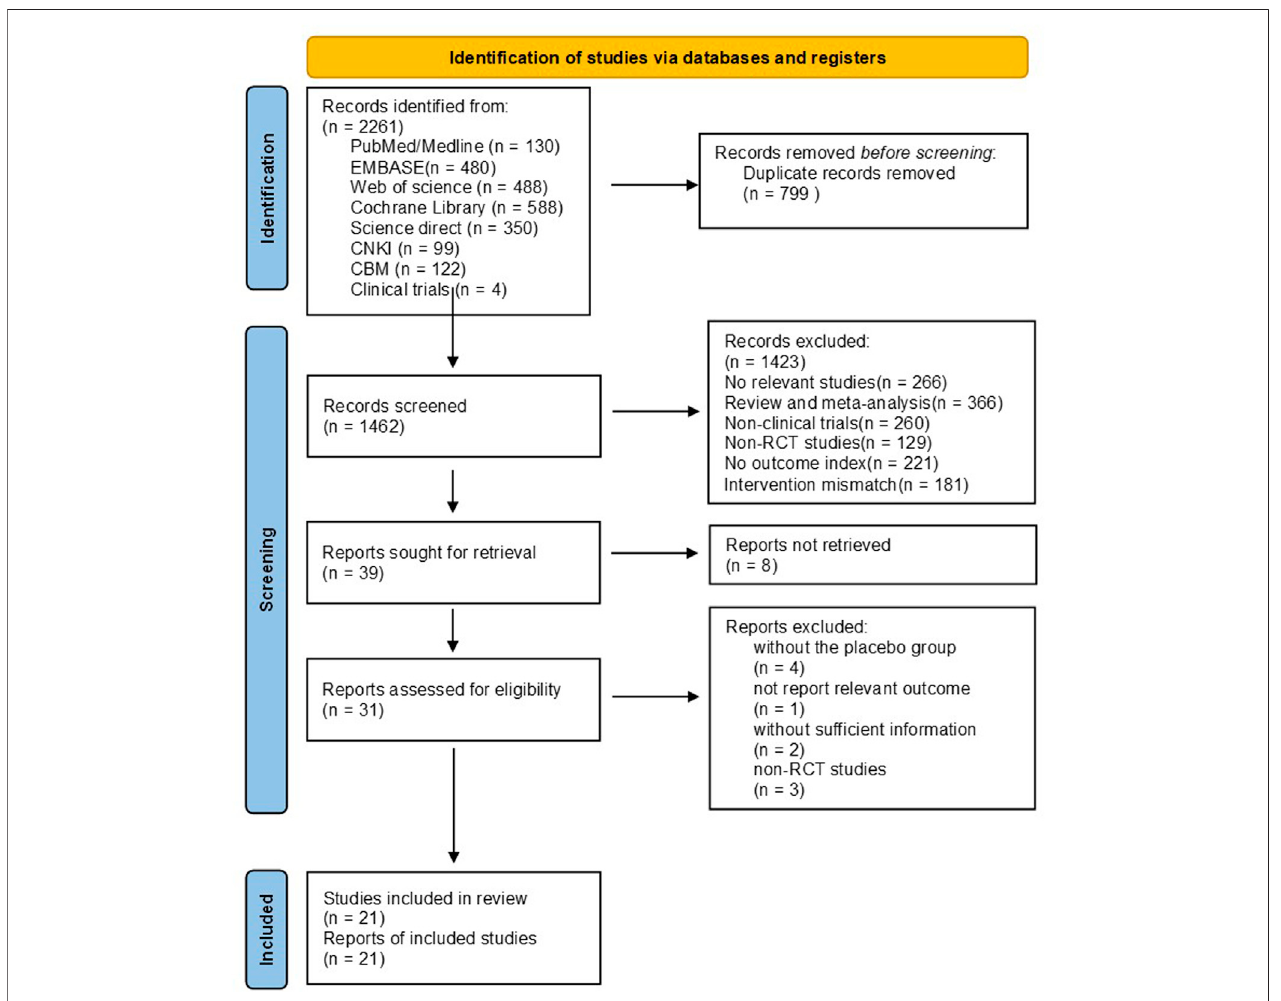
FIGURE 1 | PRISMA fl ow chart displaying the search process and study